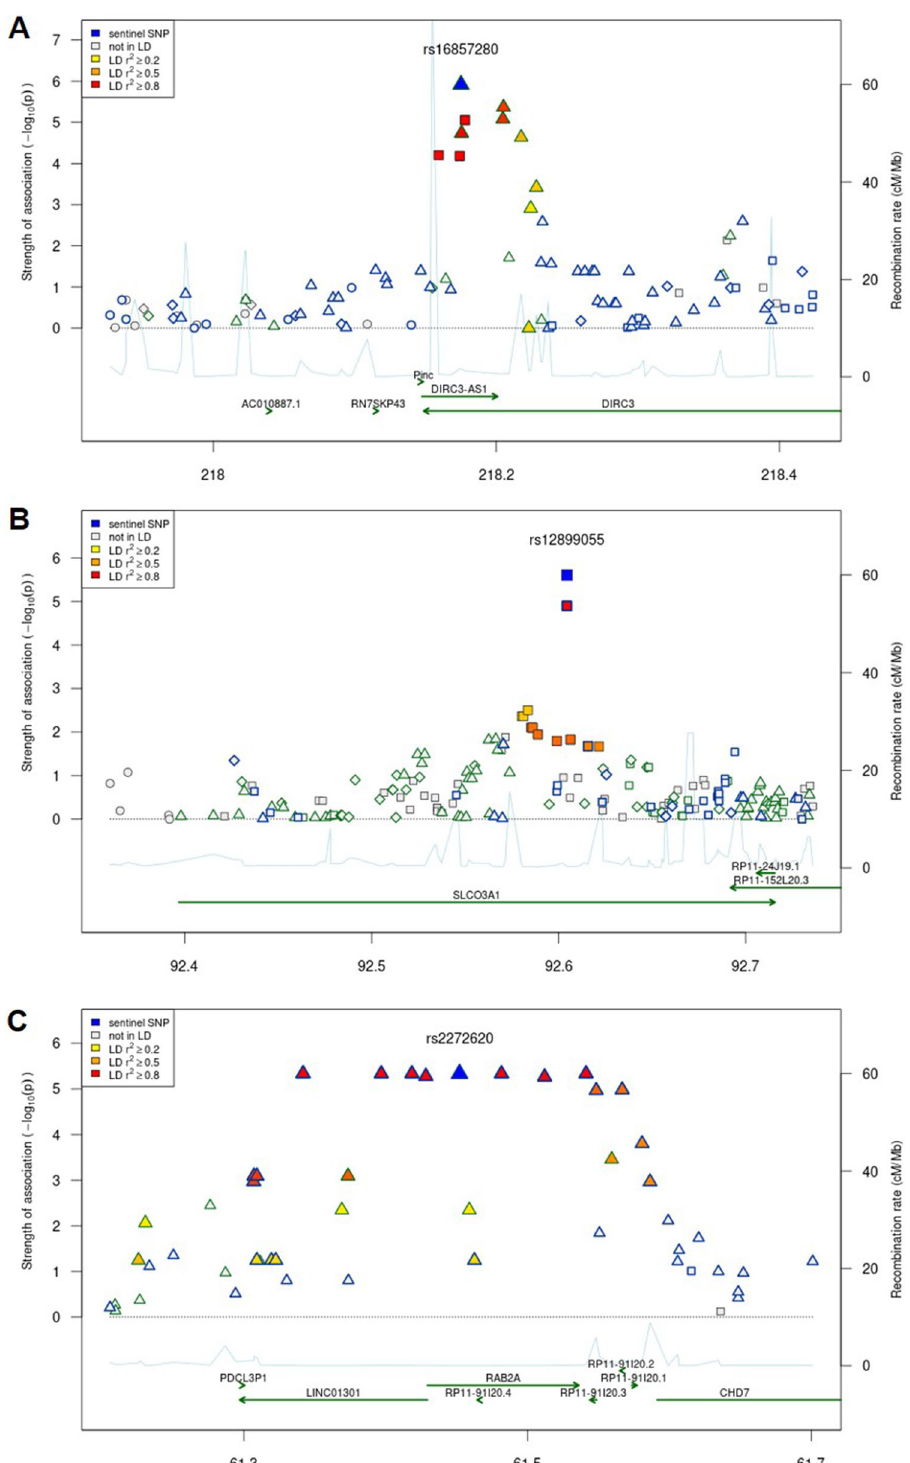
Figure 3. Regional association plots for three high ranked SNPs: ( A ) DIRC3 , ( B ) SLCO3A1 , ( C ) RAB2A . Lead variants are indicated by blue-filled shapes and other variants are colored according to r 2 values with the lead variant in each